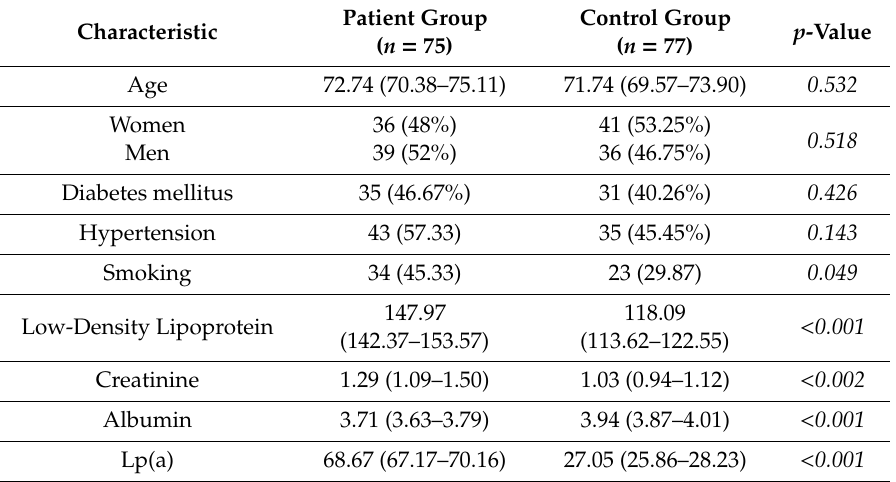
Table 1. Baseline characteristics of the study